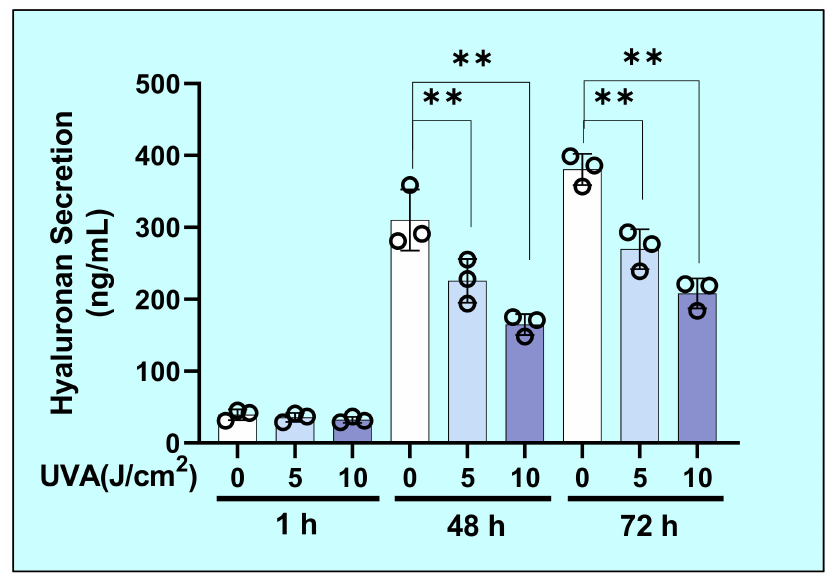
Figure 2. UVA decreases hyaluronan (HA) secretion by HDFs in culture. After HDFs were exposed to UVA at 0, 5, or 10 J/cm 2 , HA secreted into the culture medium was measured 1, 48, and 72 h later using an HA assay kit. Values are means ± S.D. from three independent. **: p < 0.01 vs. 0 J/cm 2 .